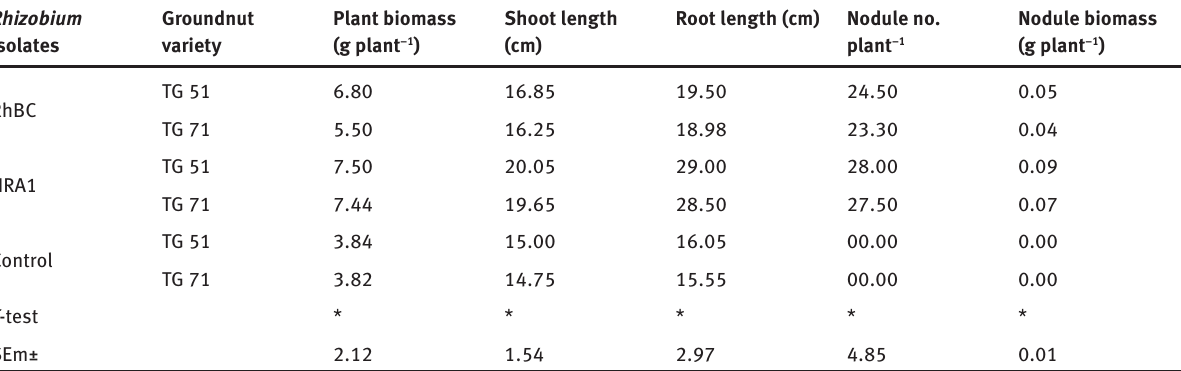
Table 4: Effect of Rhizobium isolates on dry biomass, root length, shoot length, nodulation, nitrogen content and leaf colour score of groundnut under pot culture